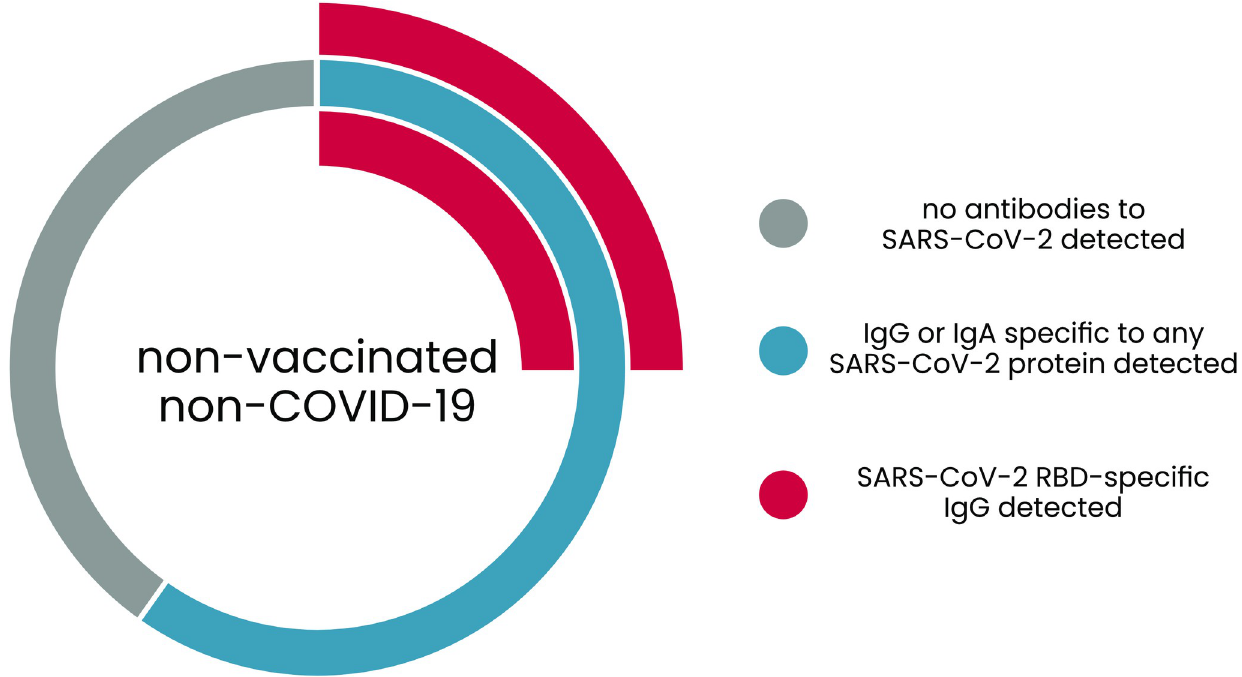
Fig 3. Fraction of the investigated population immune to SARS-CoV-2: Patients positive for IgG and IgA.